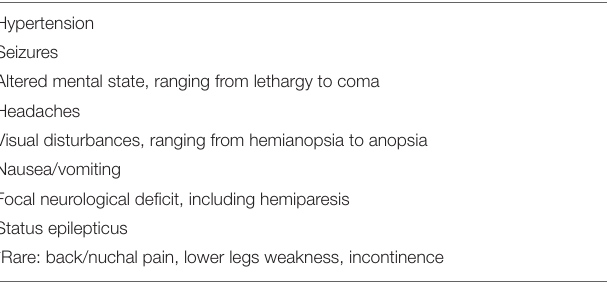
TABLE 2 | Clinical symptoms and signs in children with posterior reversible encephalopathy